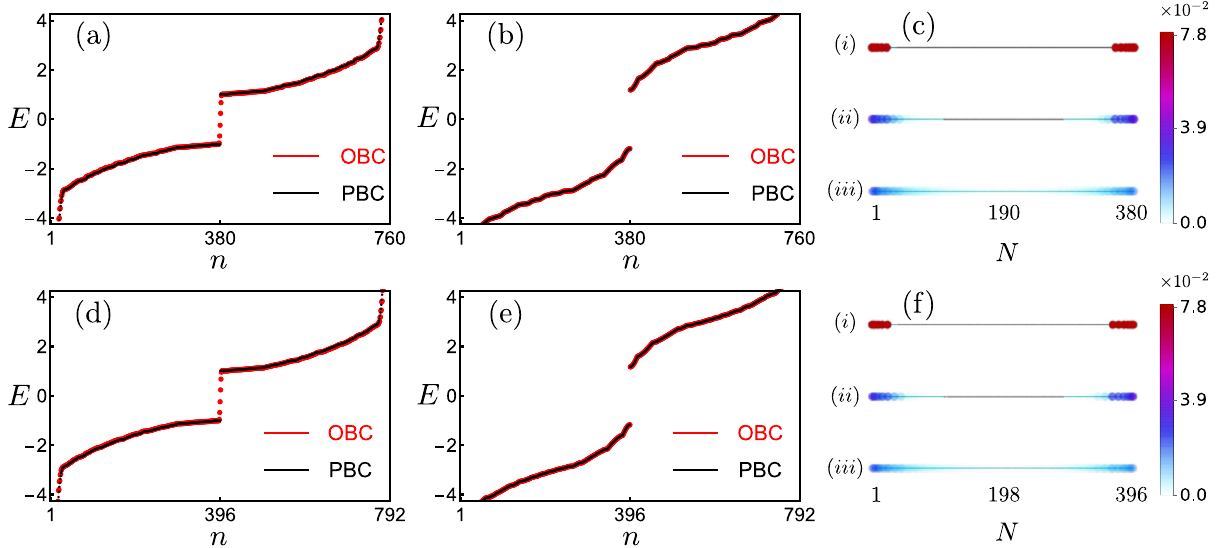
Fig. 2 Bulk-boundary correspondence of a projected Chern insulator in one dimension. The underlying 1D chain is embedded in a parent 2D square lattice